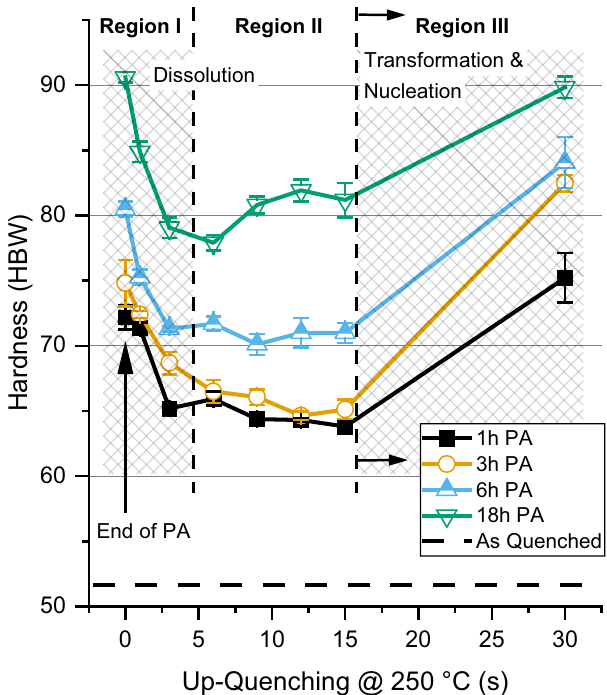
Fig. 2 Hardness evolution due to up-quenching after pre-annealing. Hardness measurements were performed following a single application of up-quenching at durations of 1 – 30 s at 250 °C to specimens pre-annealed (PA) for 1 – 18 h at 100 °C. The rapid drop in hardness within the fi rst 3 s is associated with cluster dissolution, while the latter increase is linked to precipitation and transformation. The error bars for each hardness measurement were determined from at least fi ve hardness indents and represent one standard